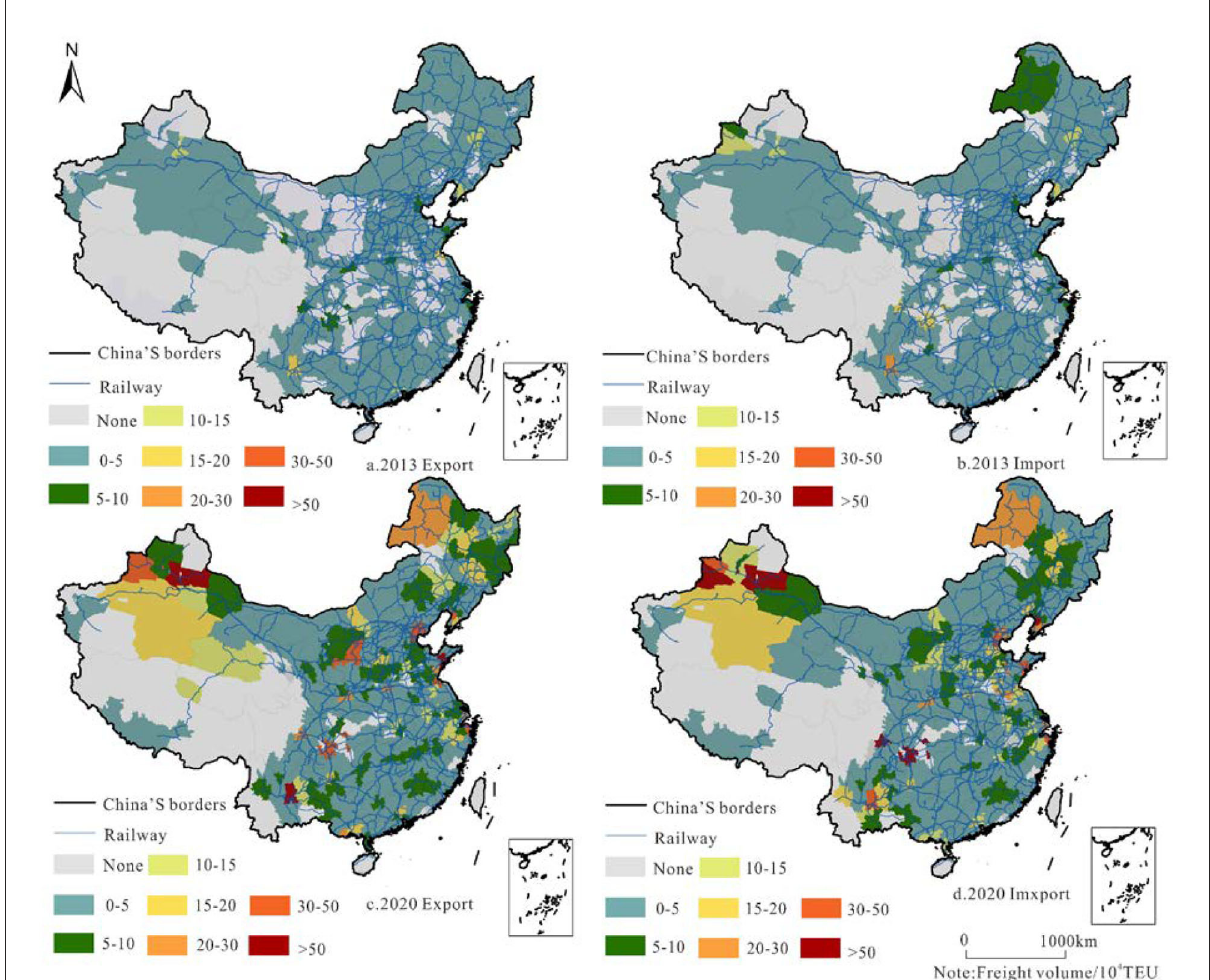
FIGURE5 Export/import pattern and evolution of China’s railway container freight in 02013/2020.